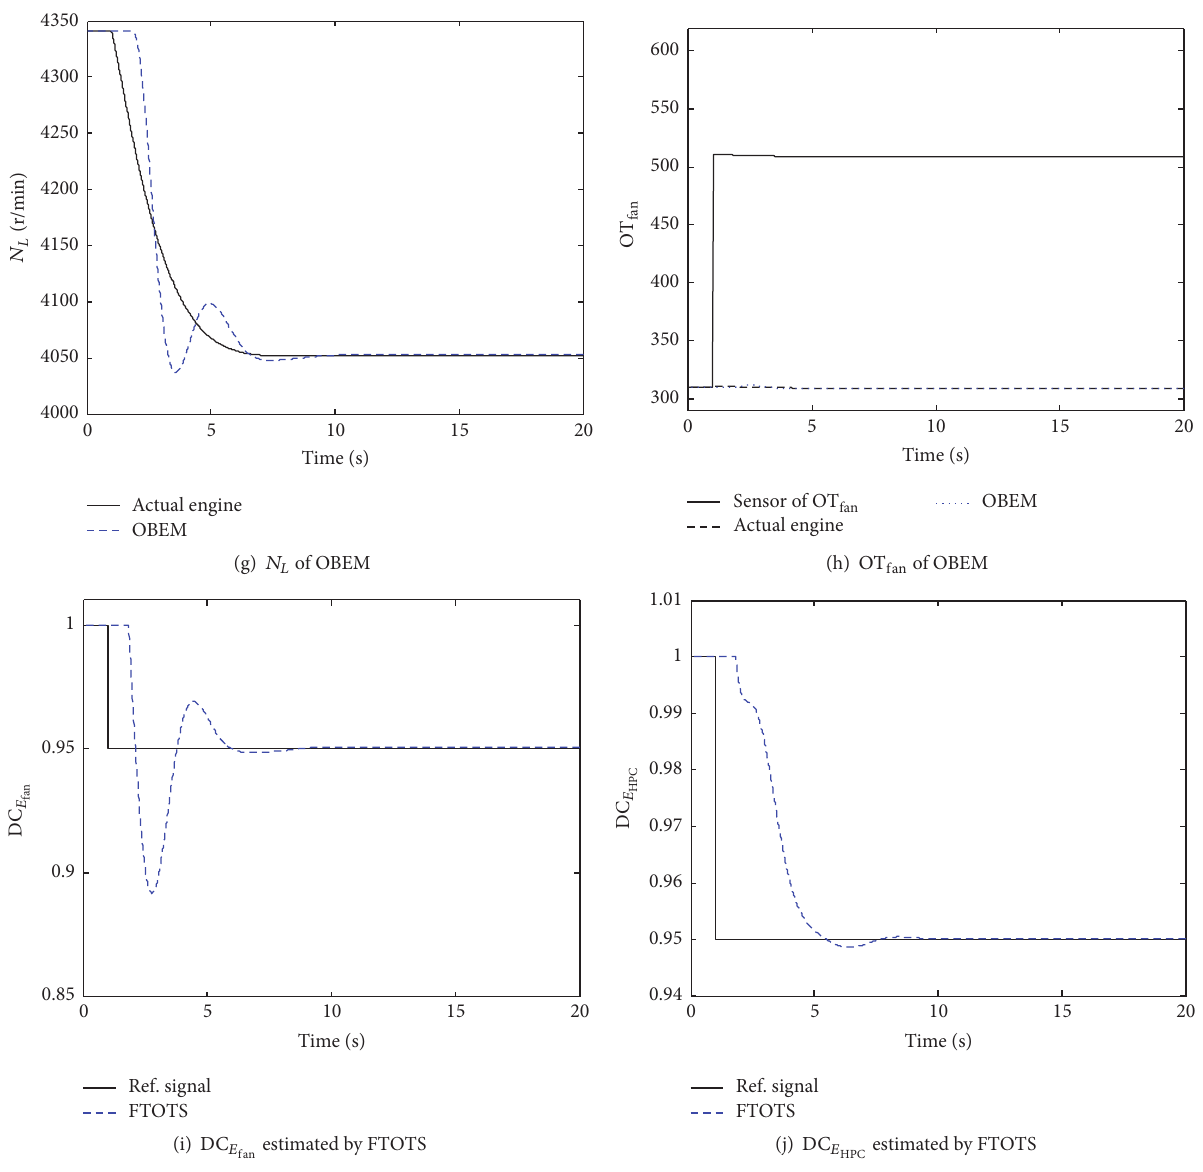
Figure 12: Simulation results of switching process of